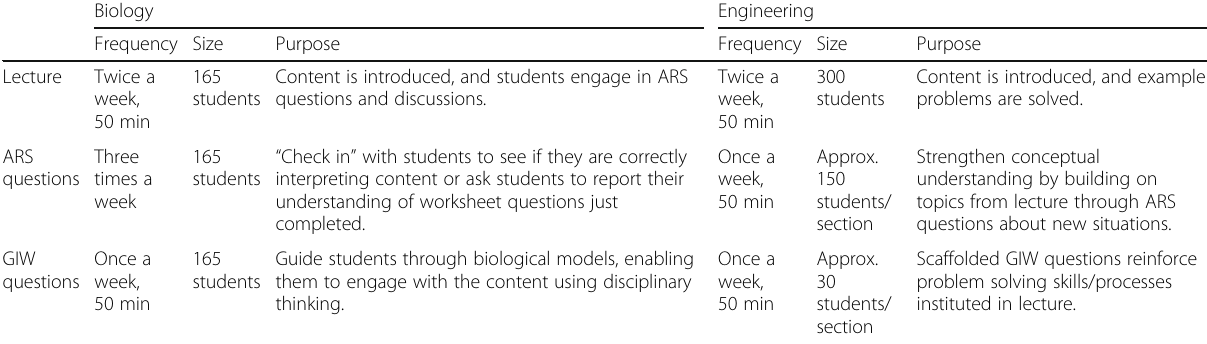
Table 2 Alignment across different elements of the two courses